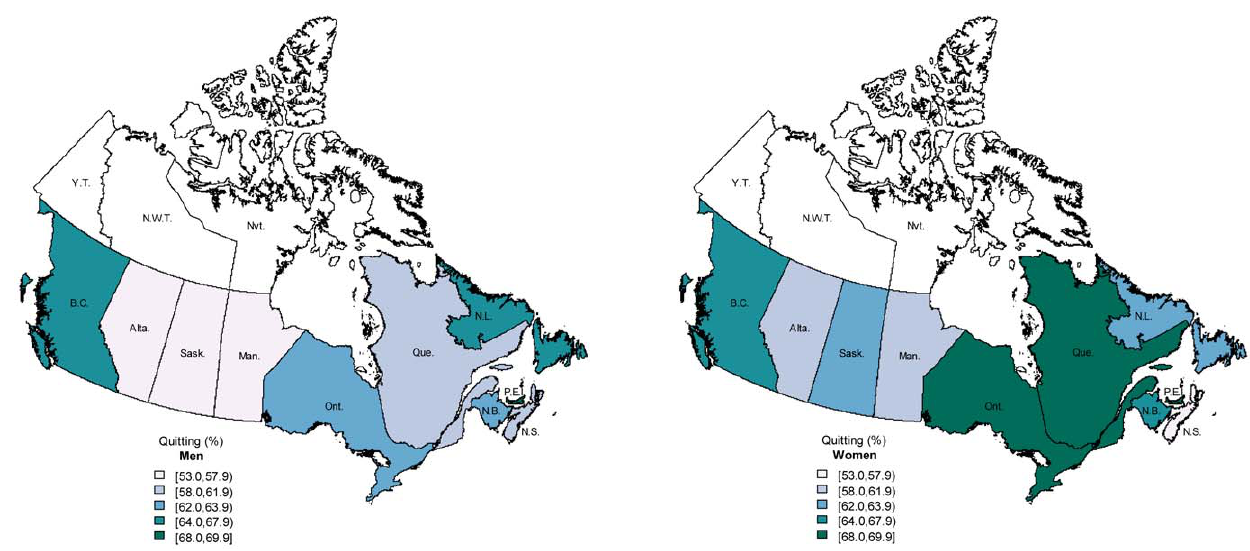
Figure 2. Adjusted prevalence of quitting in Canadian provinces for men (left) and women (right) aged 15 years and above, Canadian Tobacco Use Monitoring Survey 2010. Darker colours indicate higher prevalence. Estimates adjusted for age, sex, marital status, occupation, education. Province name abbreviations: Alta. Alberta; B.C. British Columbia; Man. Manitoba; N.B. New Brunswick; N.L. Newfoundland; N.S. Nova Scotia; O.N. Ontario; P.E.I. Prince Edward Island; Que. Quebec; Sask. Saskatchewan; data not available for Yukon Territory (Y.T.), Northwest Territories (N.W.T), or Nunavut (Nvt.).